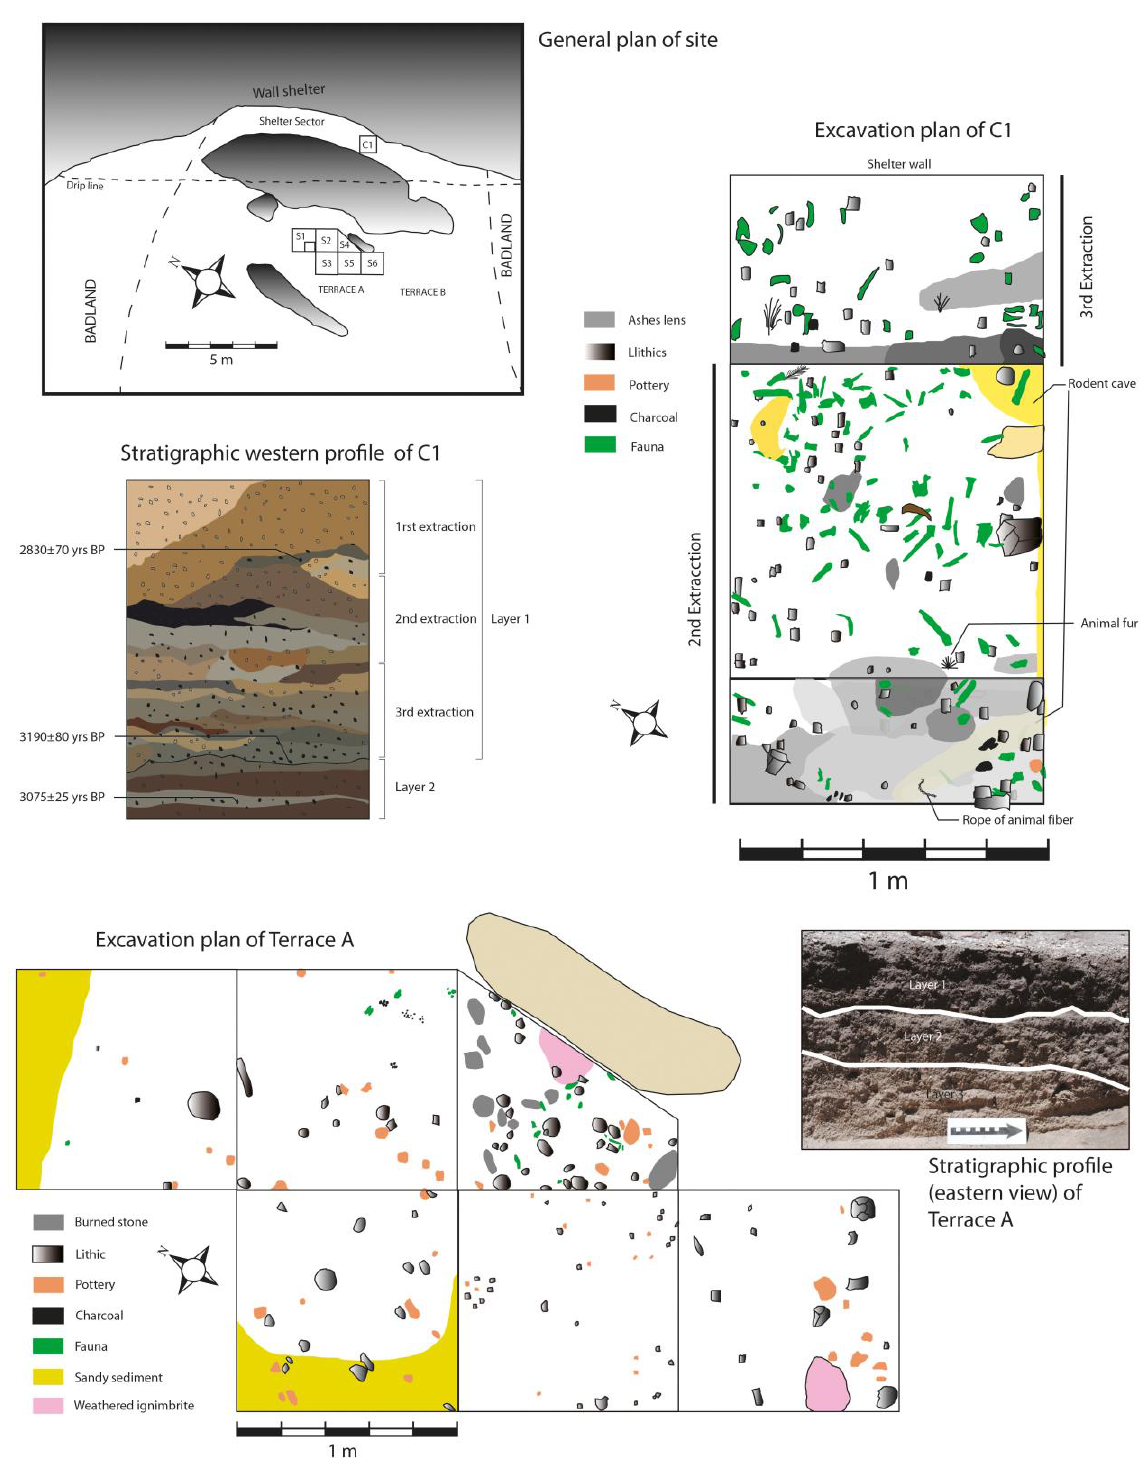
Figure 3. Morro Blanco. General view of rock shelter. Excavation plans and stratigraphic